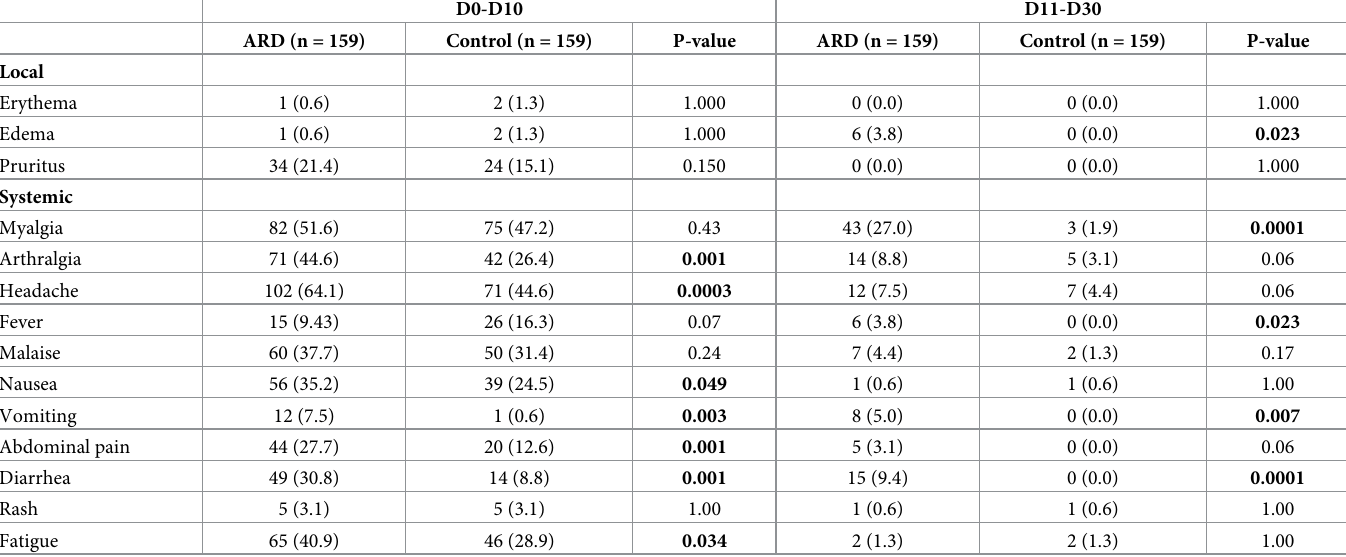
Table 5. Local and systemic side effects after YFV in 159 autoimmune rheumatic diseases (ARD) patients and 159 health